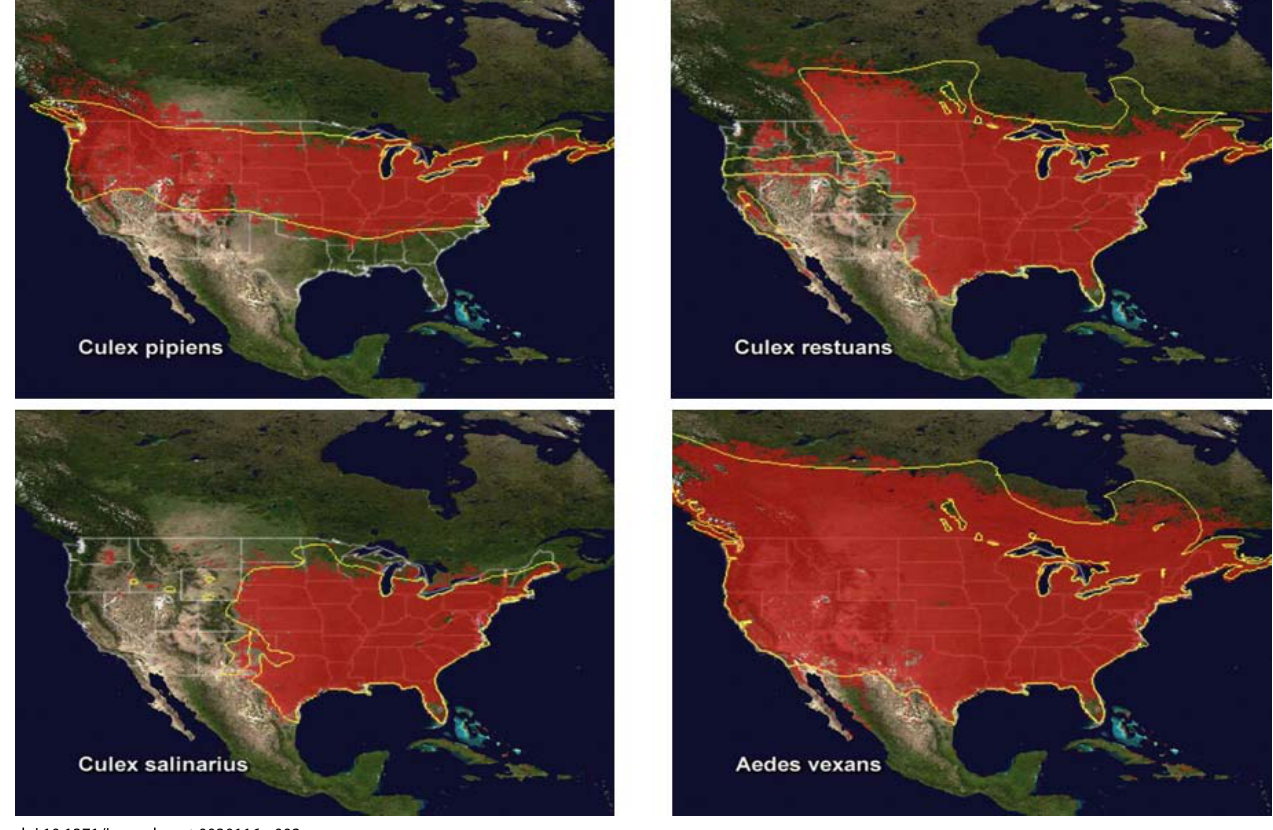
Figure 2. Maps Showing the Potential Distribution of Four Species of Mosquitoes in the United States Distribution predicted using satellite derived environmental data is in red, and recorded distribution is outlined in yellow. Image courtesy: TALA Research Group–University of Oxford.